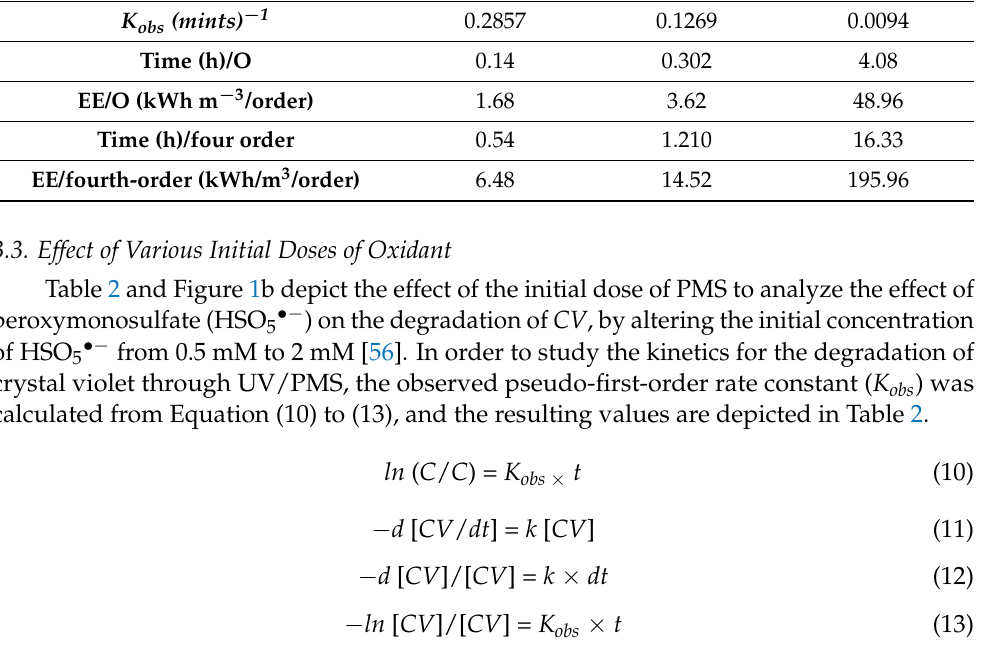
Table 2. The effect of the initial concentrations of PMS on the removal efficiency, K obs , and